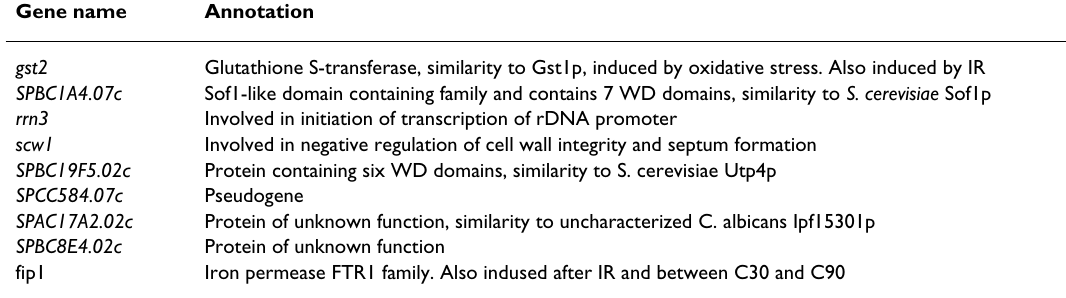
Table 1: UV-induced genes not present in the CESR UV-induced genes not present in the CESR at UV30: